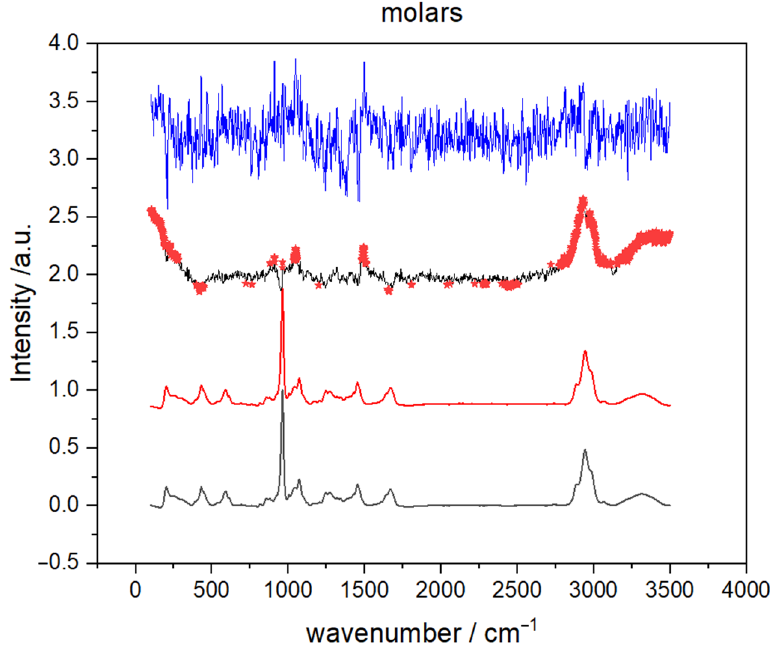
Figure 7. The average Raman spectra of molar apex male (grey line) and female (red line) teeth obtained in the spectral range between 3500–200 cm − 1 . The differential spectrum of average male and female spectra (male-female, black line) enhanced with student t-test result (red stars) and corresponding PC1 loadings (blue line).